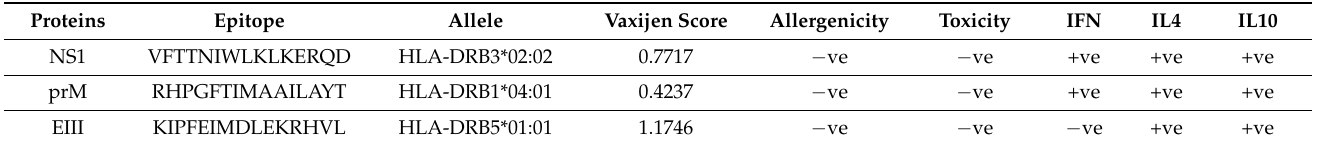
Table 4. List of selected CD4+ HTL epitopes.